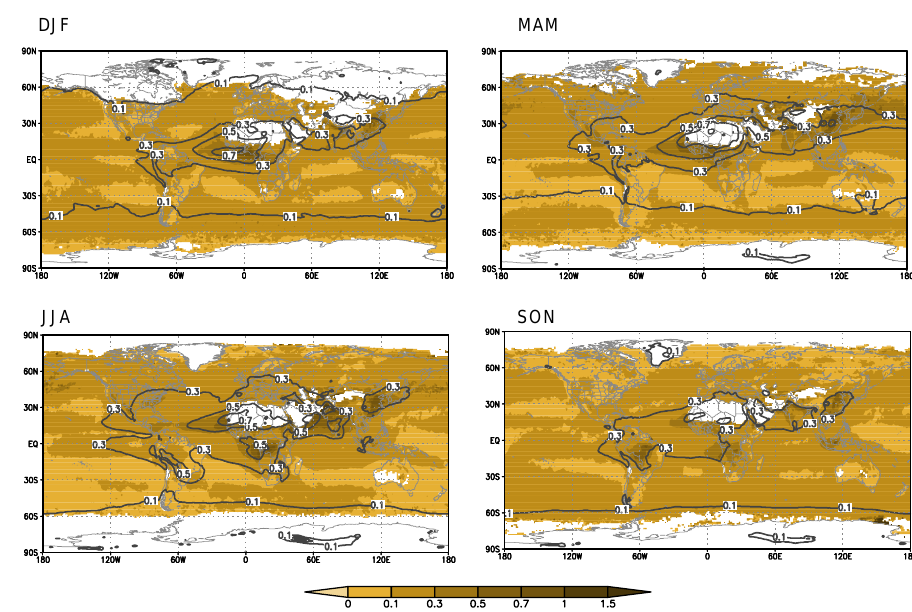
Fig. 6. Comparisons of seasonally averaged AOD between MODIS and model simulations for 2000–2004. The filled contours are for MODIS and the contour lines are for model simulations.